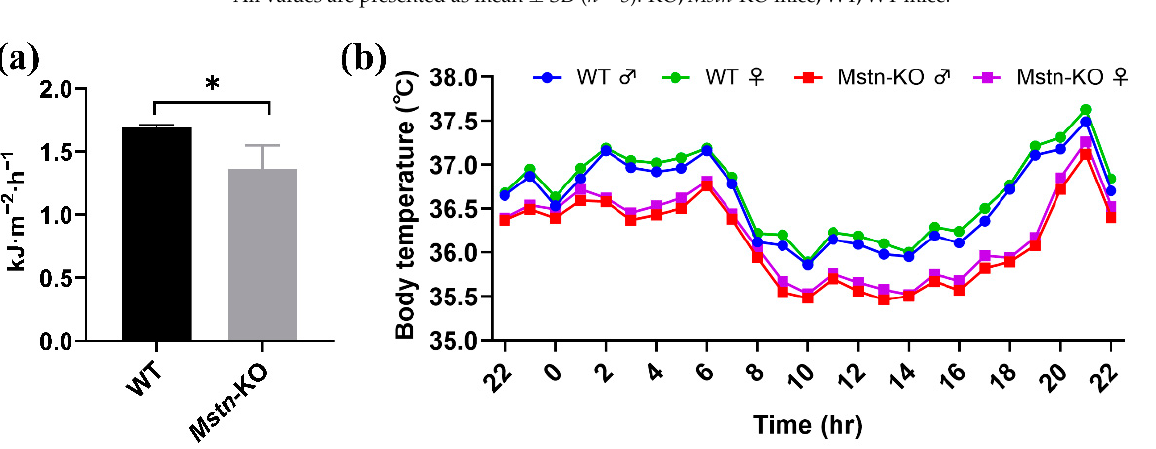
Figure 3. Mstn knockout decreases basal metabolic rate and body temperature. ( a ) Comparison of basal metabolic rate between Mstn -KO and WT mice ( n = 3). ( b ) Body temperature in WT compared with Mstn -KO male and female mice ( n = 1). All data are presented as mean ± SD. * p < 0.05; t-tests were used to calculate the p -values. Table 2. The basic energy metabolism of Mstn -KO and WT mice.